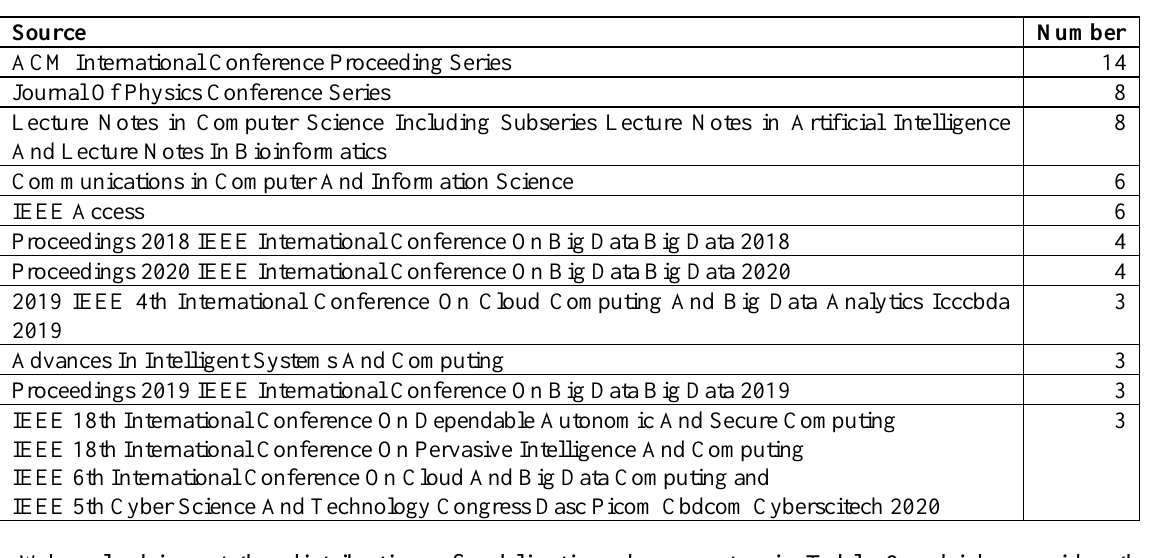
Table 8. Top 11 sources with the most